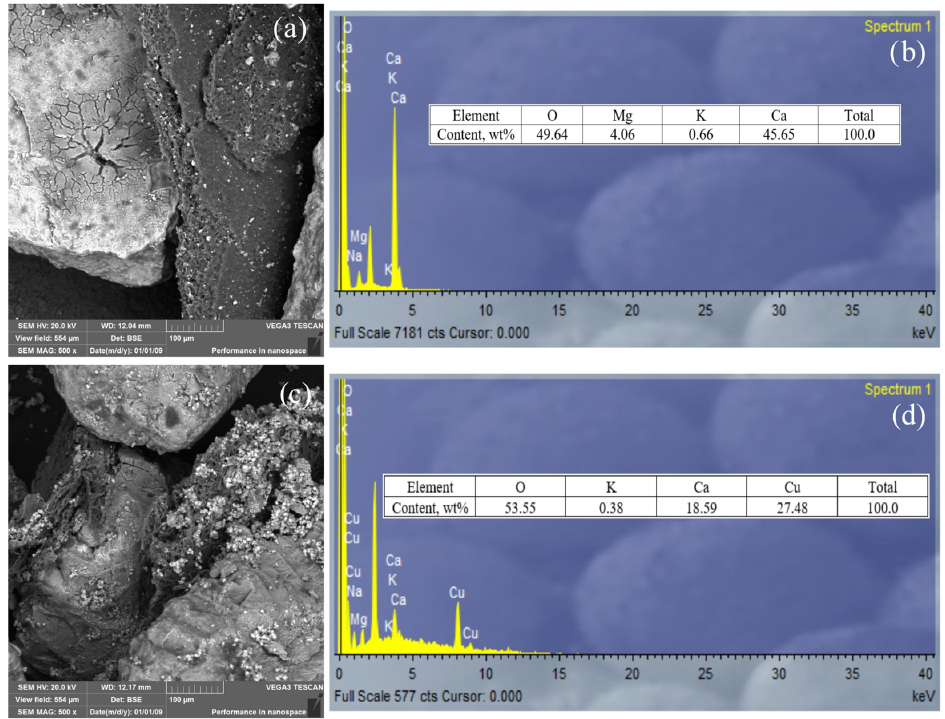
Figure 4. SEM micrographs of eggshells samples before Cu 2+ biosorption ( a ) and after the biosorption process ( c ), with the corresponding EDS spectra before ( b ) and after the biosorption process ( d ).